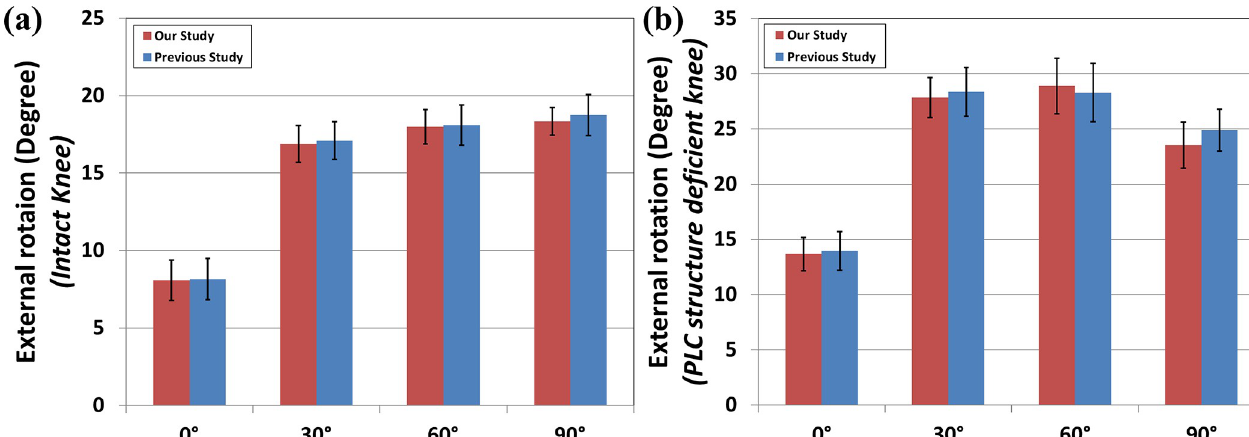
Fig 4. Comparison of the external rotation in the external rotation torque for experiment and computational simulation between the (a) intact and (b) PLC deficient conditions.